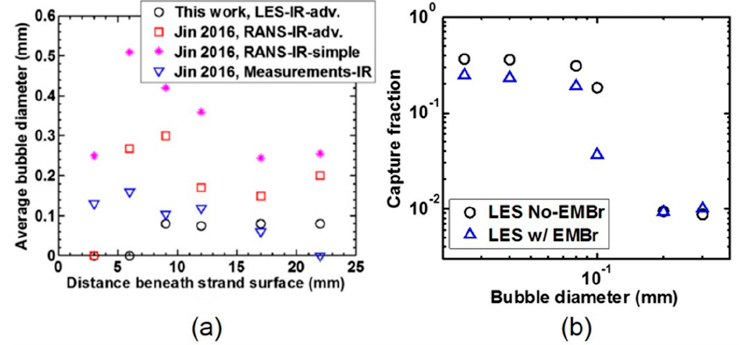
Figure 22. Captured bubble size distribution showing ( a ) the variation with distance beneath the strand surface and ( b ) the effect of double-ruler EMBr on capture fraction [138].